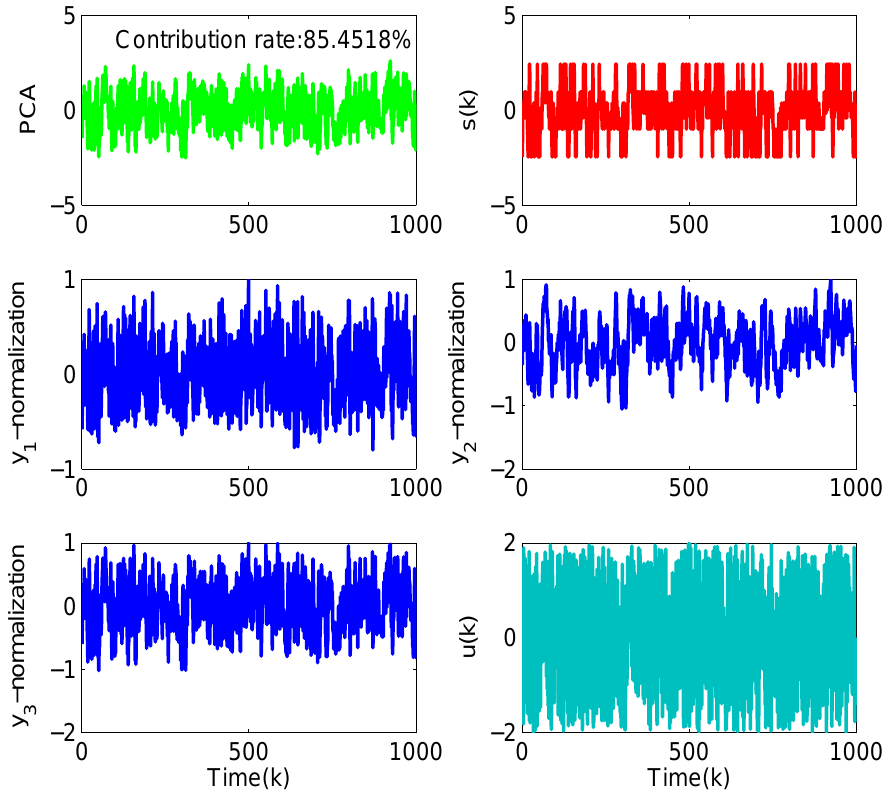
Figure 4. The curves of I/O data, PCA information, and class